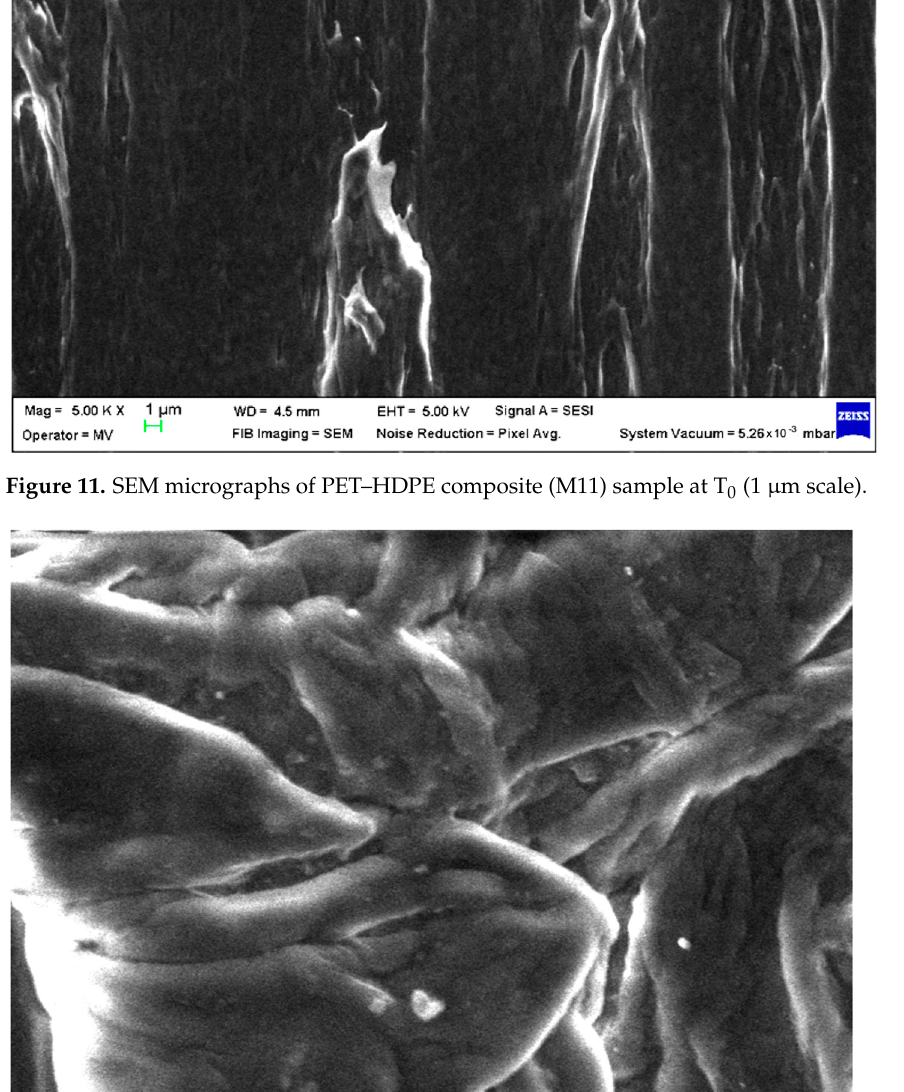
Figure 12. SEM micrographs of PET–HDPE–Al composite (M12) sample at T 0 (1 μ m scale).